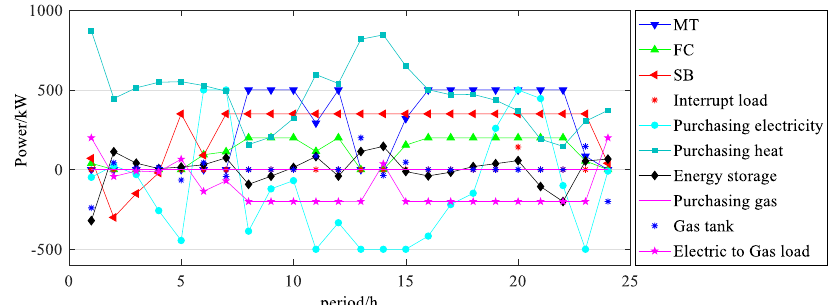
Figure 6. An IES optimization operation scheme for a typical winter day (Micro-turbine: MT, FC: Fuel Cell, SB: Storage Battery).